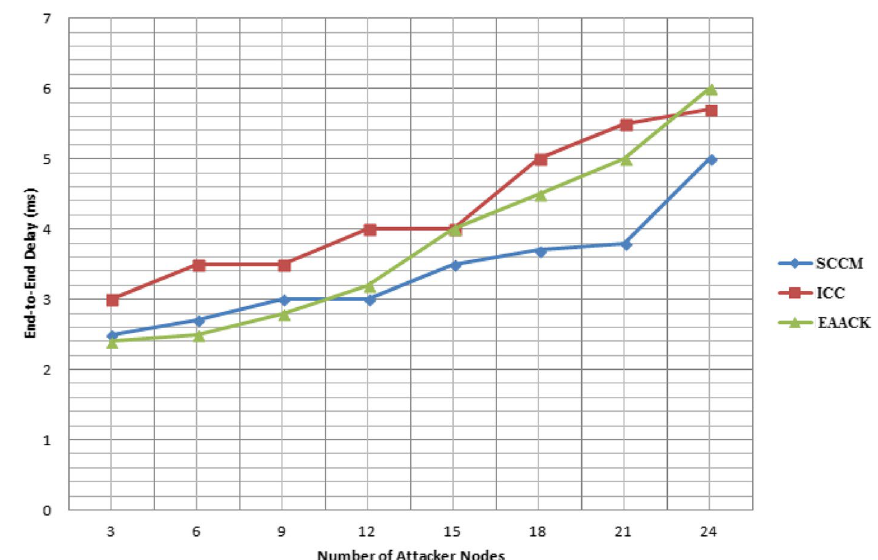
Fig. 13 Average end-to-end delay vs number of attacker